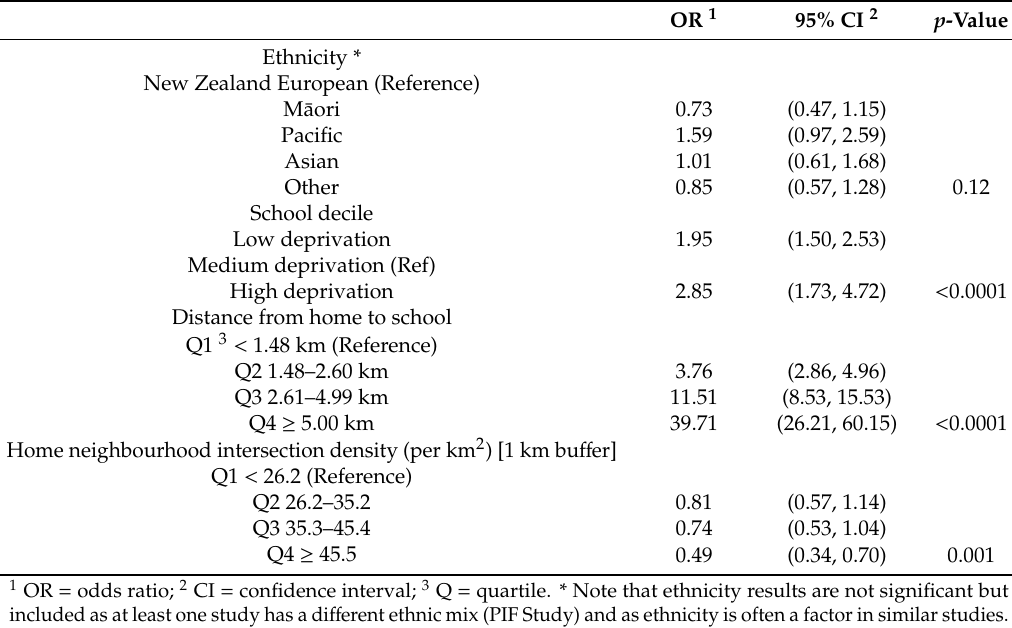
Table 2. Final multivariate model of correlates of travelling to school by car.